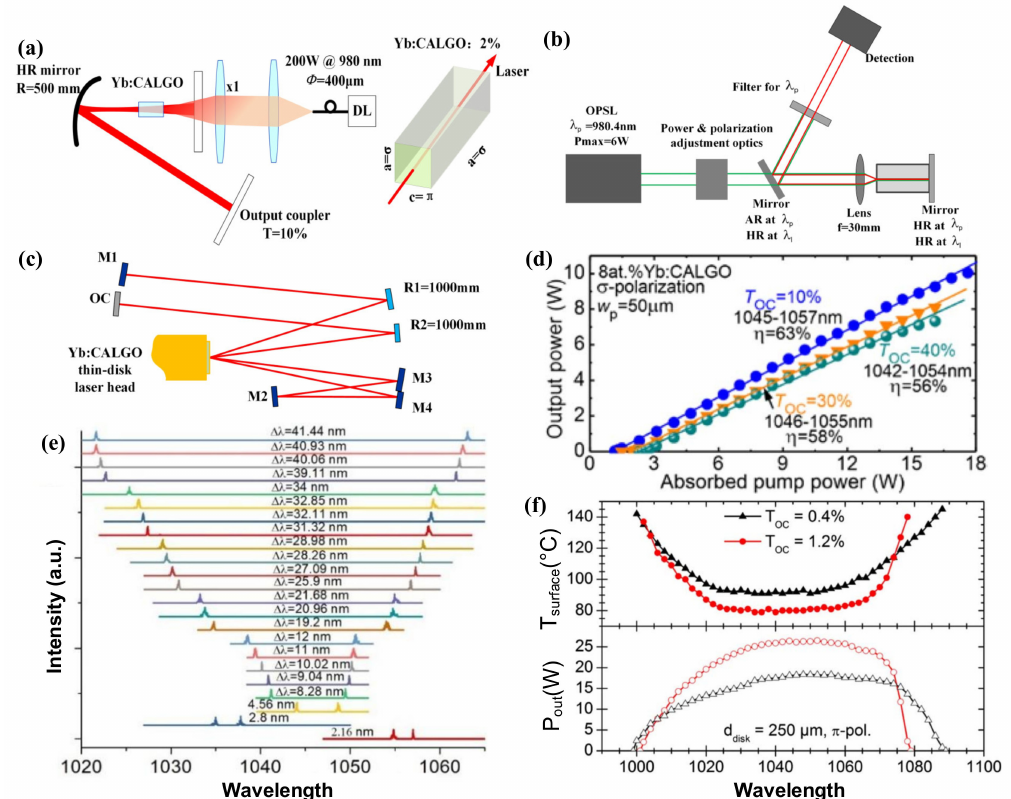
Figure 2. ( a ) A high-power Yb:CALGO oscillator [58]. ( b ) The first fs-laser-written waveguide laser in Yb:CALGO [59]. ( c ) High-efficiency Yb:CALGO thin disk [63]. ( d ) The performance of the first Yb:CALGO microchip laser [41]. ( e ) Dual- wavelength [64] and ( f ) broad wavelength-tunable [43] lasers. ( a – c ) are redrawn based on refs. [58,59,63], respectively. ( d ) Reprinted with permission from ref. [41], ©The Optical Society. ( e ) Reprinted with permission from ref. [64], SPIE. ( f ) Reprinted with permission from ref. [43], ©The Optical